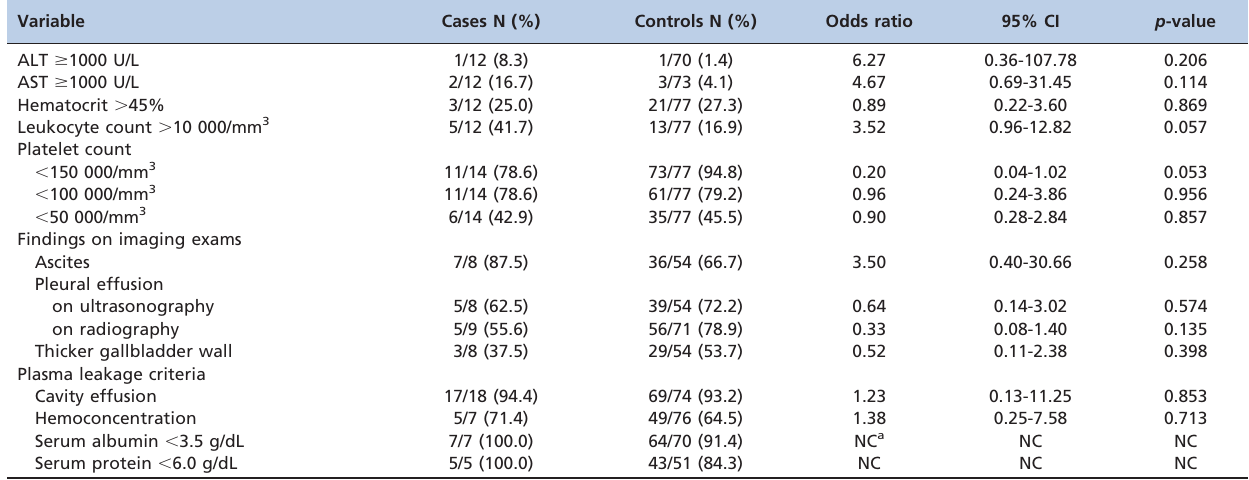
Table 3 - Laboratory and imaging findings of children with severe dengue.